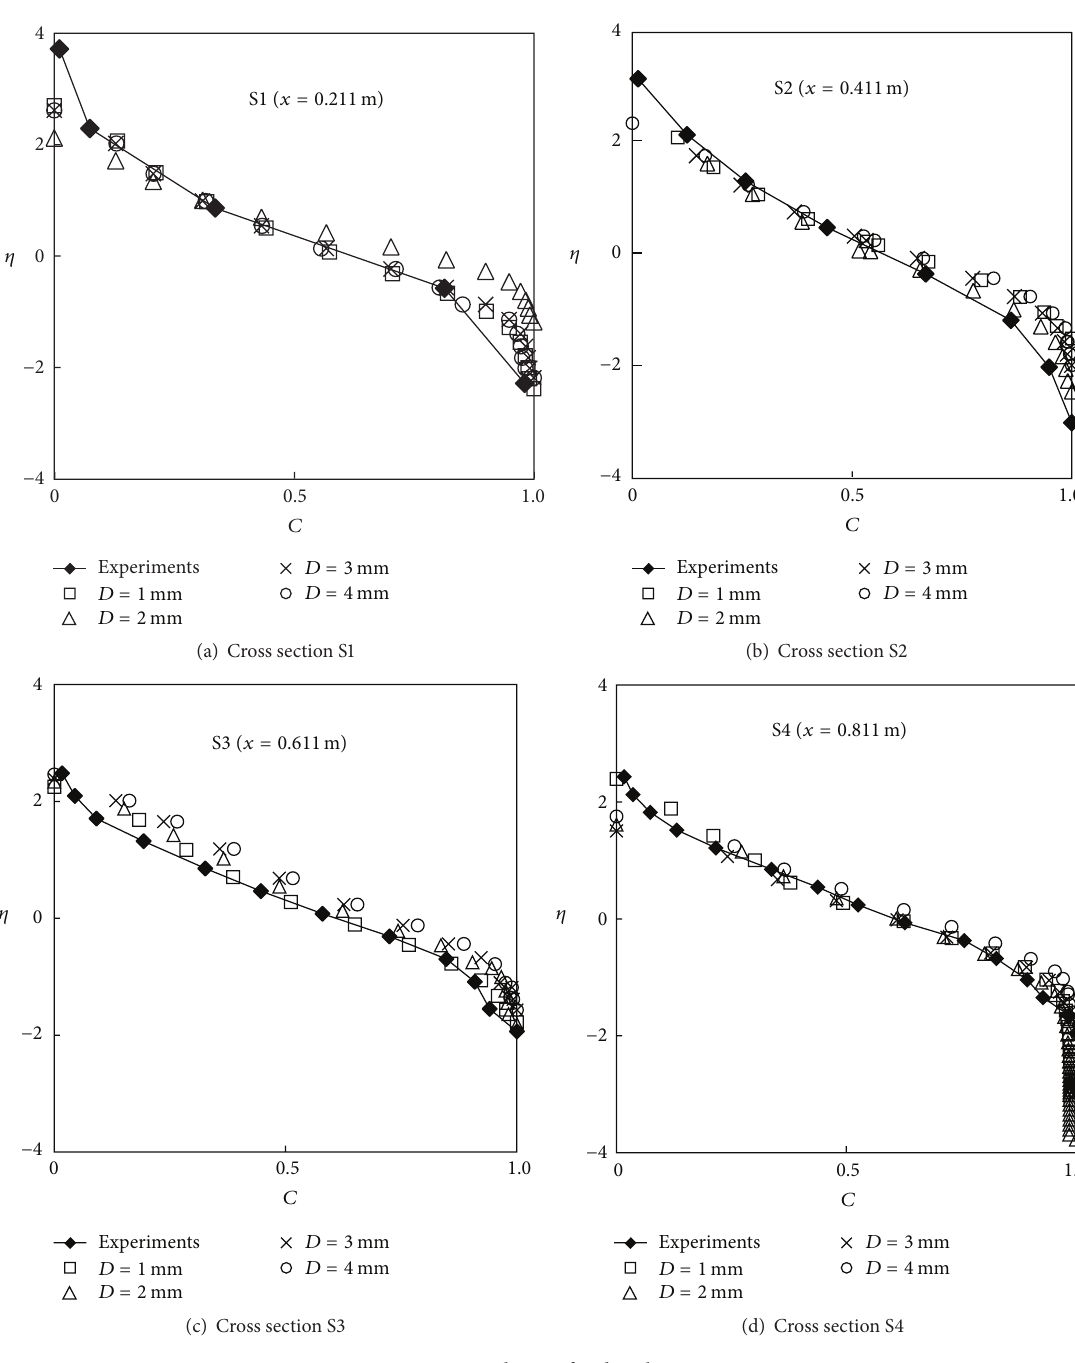
Figure 7: Similarity of 𝐶